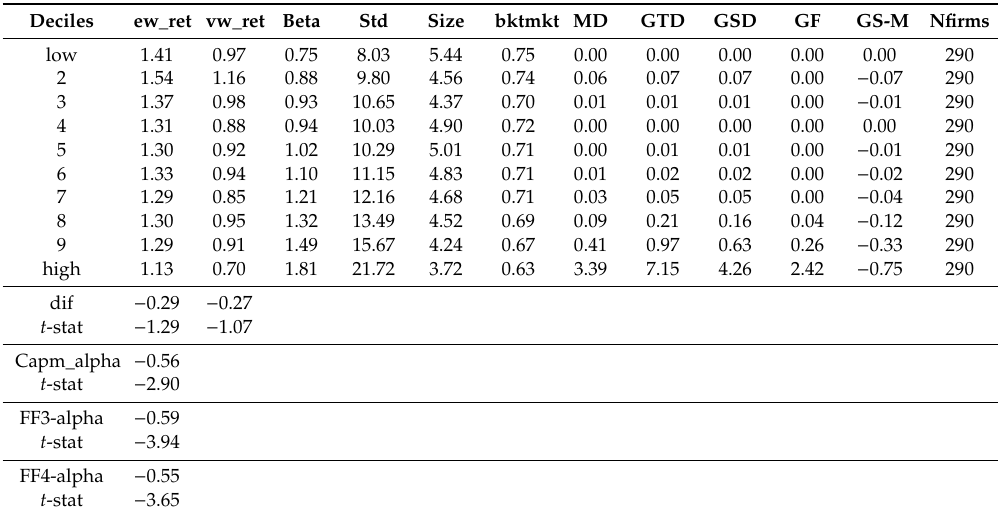
Table 5. Average returns from decile portfolios sorted by Geske’s forward default probability. From the data for July 1963 to December 2013, at the end of each month, we used the most recently calculated Geske’s forward default probability for each firm to sort all stocks into deciles. We then calculated the equally weighted and value-weighted returns over the next month. The returns are the average monthly returns over the sample period. Portfolio 1 is the portfolio with the lowest default risk and Portfolio 10 is the portfolio with the highest default risk. High-Low is the di ff erence between the high and low default risk portfolios. t -values are calculated from Newey-West standard errors. Alphas are calculated using the CAPM, the three-factor Fama-French, and the four-factor model (Fama-French three-factor plus